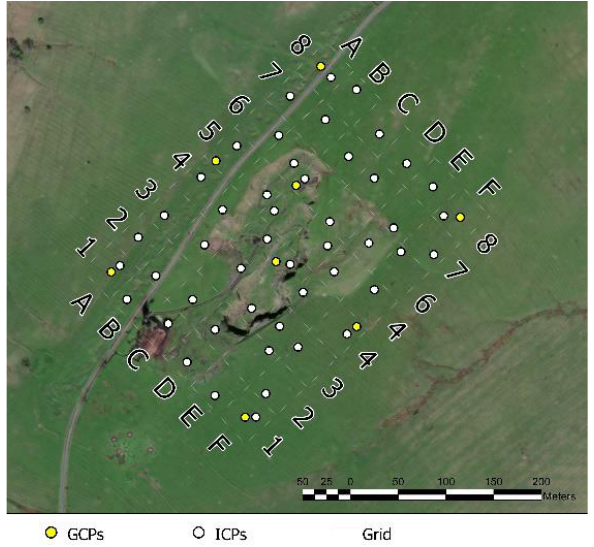
Figure 1. Test field target distribution at Wards Hill quarry, Northumberland, UK, Map data: Google Earth 2021.